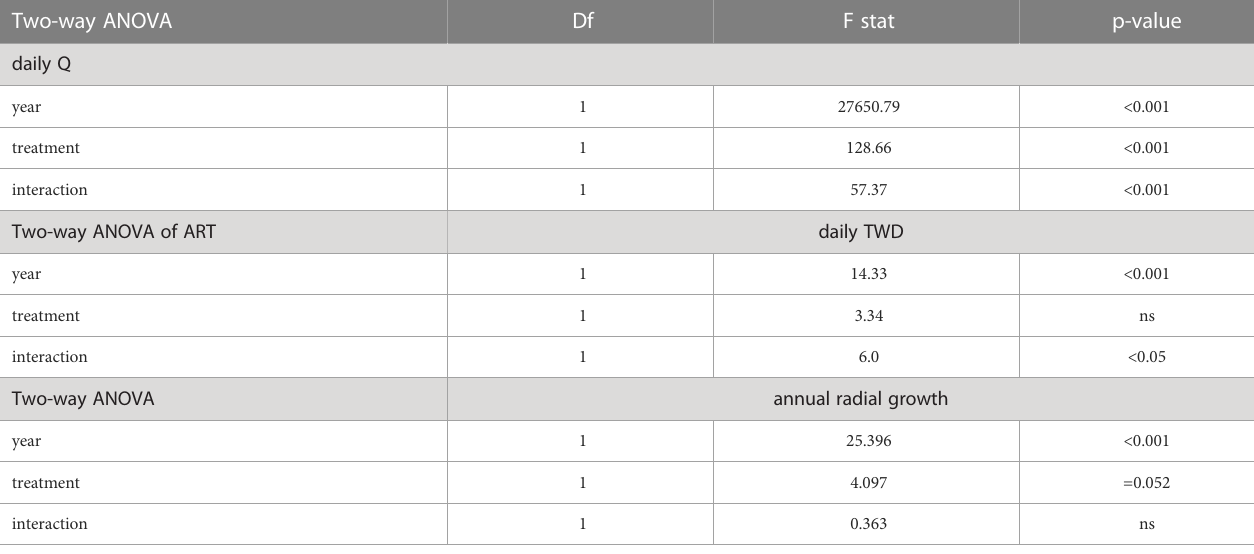
TABLE 2 Statistical test results for daily modeled speci fi c sap fl ow (Q) and daily modeled tree water de fi cit (TWD) and measured annual radial growth. Two-way ANOVA